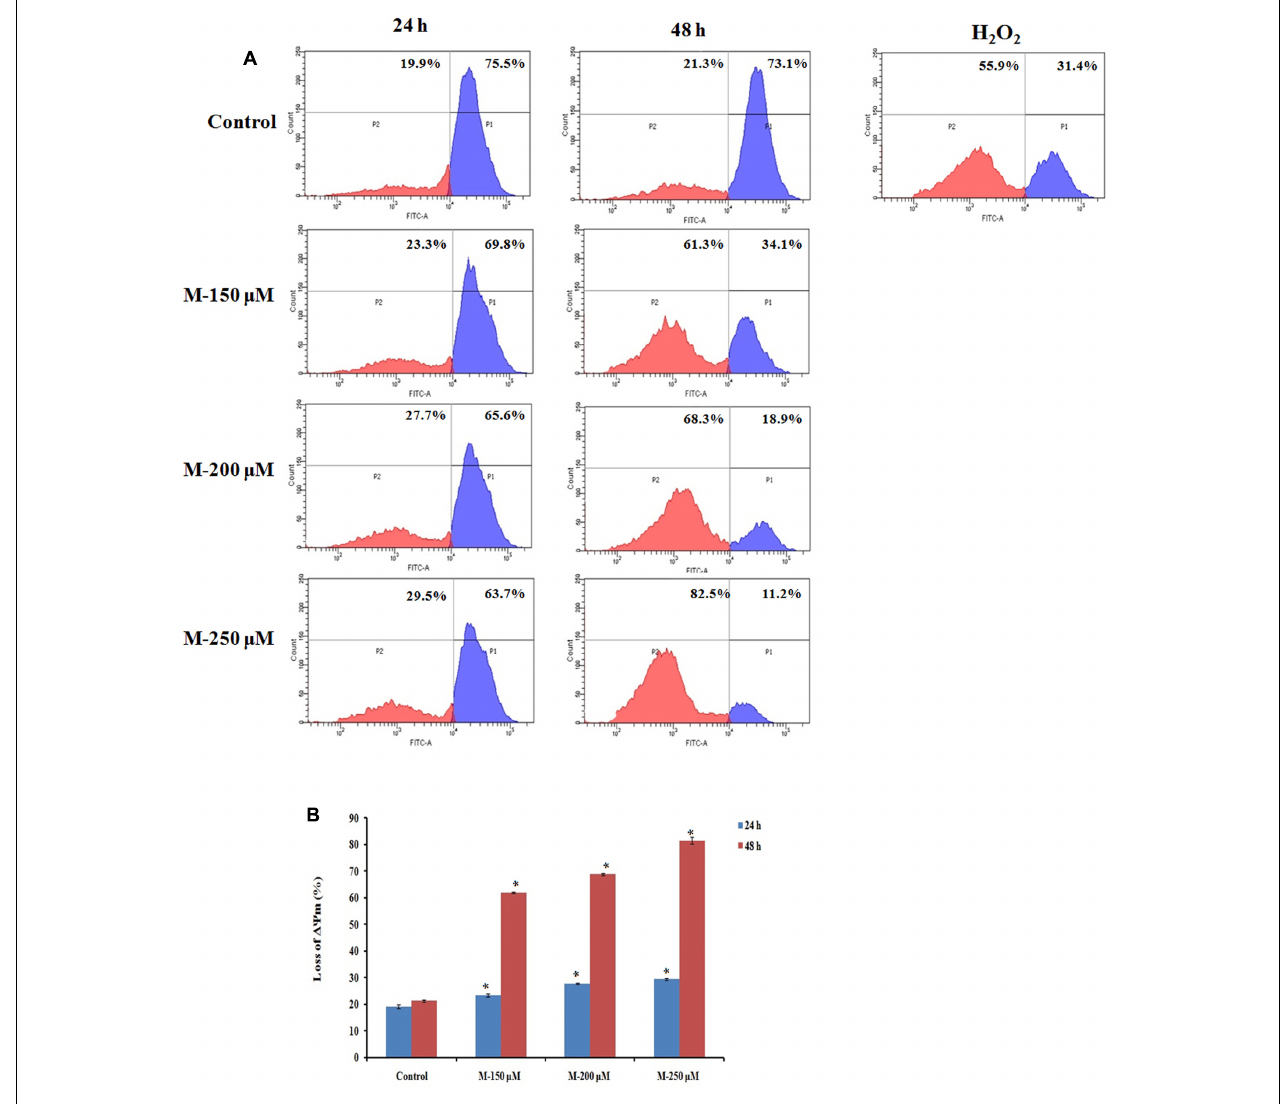
FIGURE 4 | Quantification of loss of mitochondrial membrane potential by Rhodamine 123 staining. SW480 cells were treated with various concentrations of morin (150, 200, and 250 µ M) for 24 and 48 h and H 2 O 2 (200 µ M) for 2 h. After incubation, cells were stained with Rhodamine 123 analyzed using flow cytometer. (A) Representative results. (B) Data analyzing fluorescence intensity from triplicate measurements. M (150, 200, and 250 µ M): Morin (150, 200, and 250 µ M). Significance levels between different groups were determined by using one way ANOVA, followed by Duncan’s multiple range test. ∗ p ≤ 0.05 versus